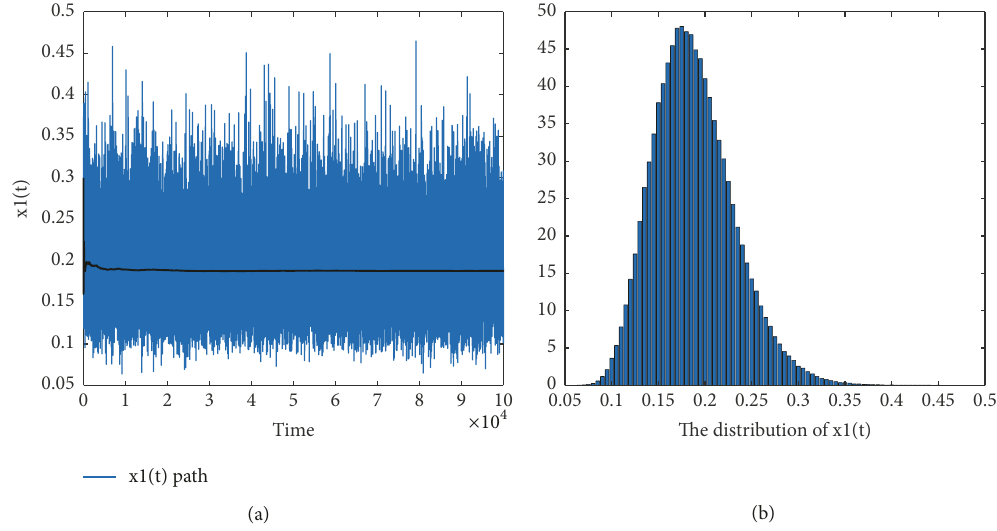
Figure 5: (a) is the time series of 𝑥 1 (𝑡) with initial value 𝑥 1 (0) = 0.3 ; (b) is the distribution interval of 𝑥 1 (𝑡) .